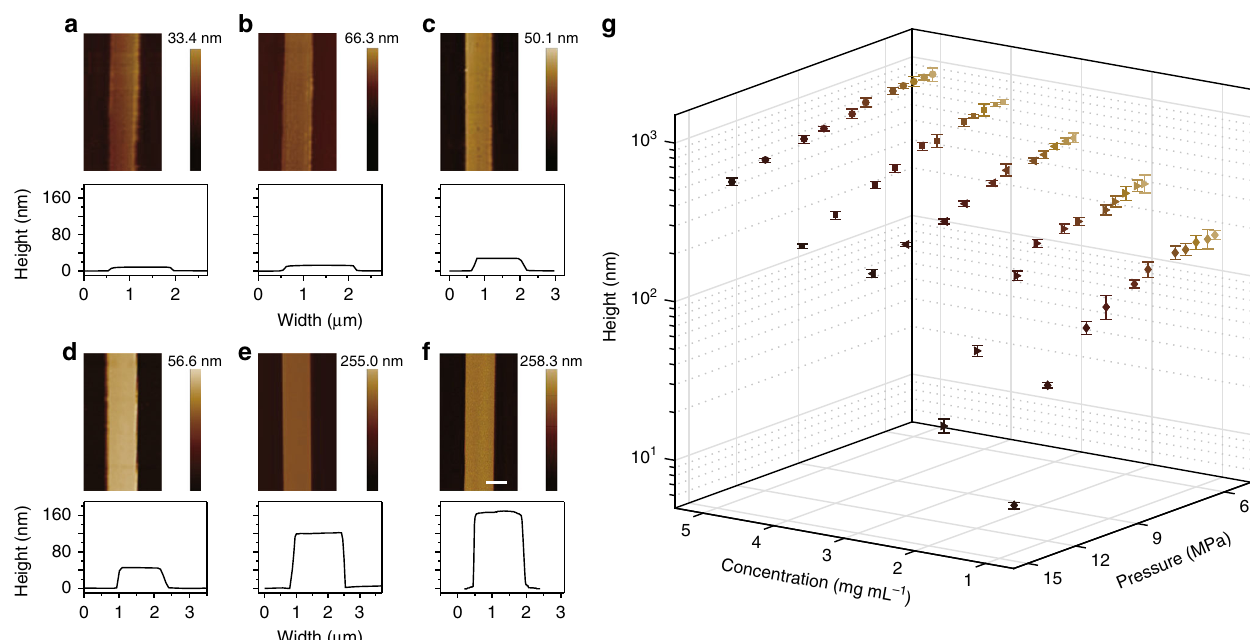
Fig. 3 The size control of 1D organic arrays by tuning pressure and solution concentration. a – f AFM images of an individual organic single-crystal nanobelt with the width of ca . 1.5 μ m but different heights varying from 8.3 nm to 168.1 nm. Their operating conditions are a and b 1 mg mL − 1 14 MPa, c and d 1 mg to 5 mg mL − 1 under different pressures varying from 5.5 to 14 MPa. Scale bars: f 1 μ